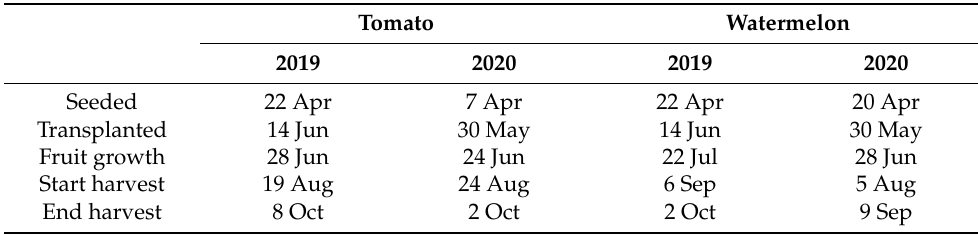
Table 3. Vegetable management timelines in 2019 and